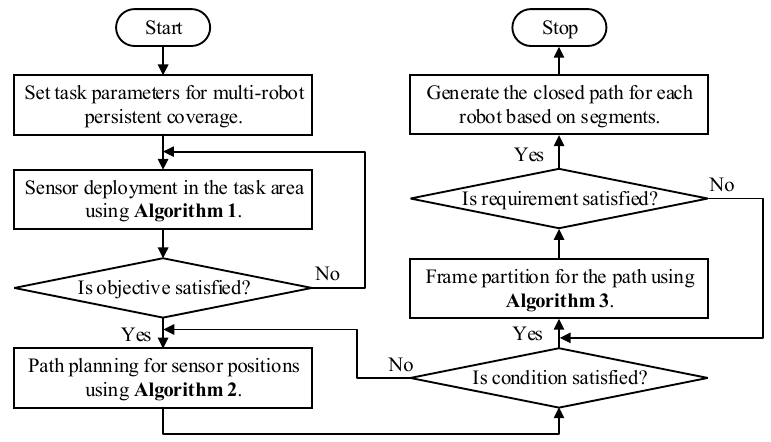
Figure 11. The flow chart of the combinatorial method proposed for cooperative persistent coverage.